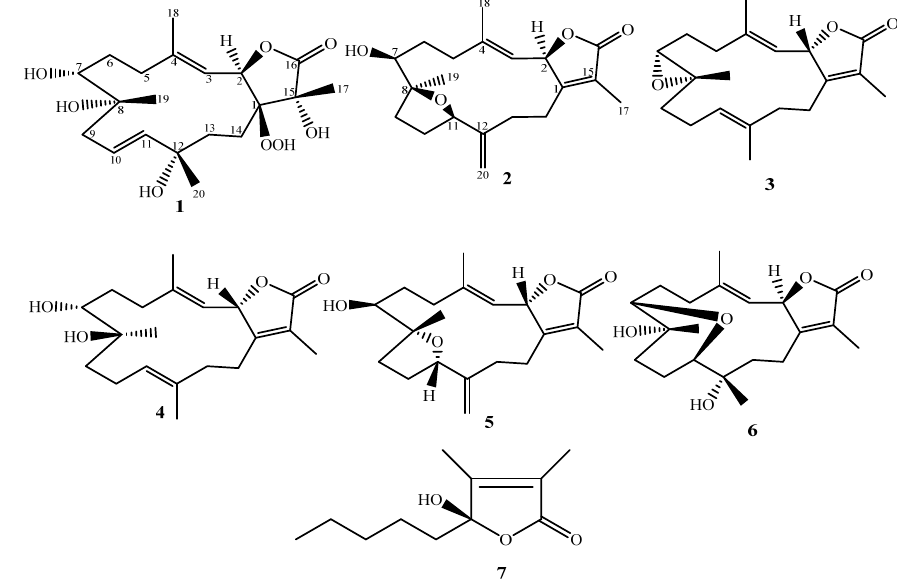
Figure 1. Structures of the isolates from S. conovlutum .